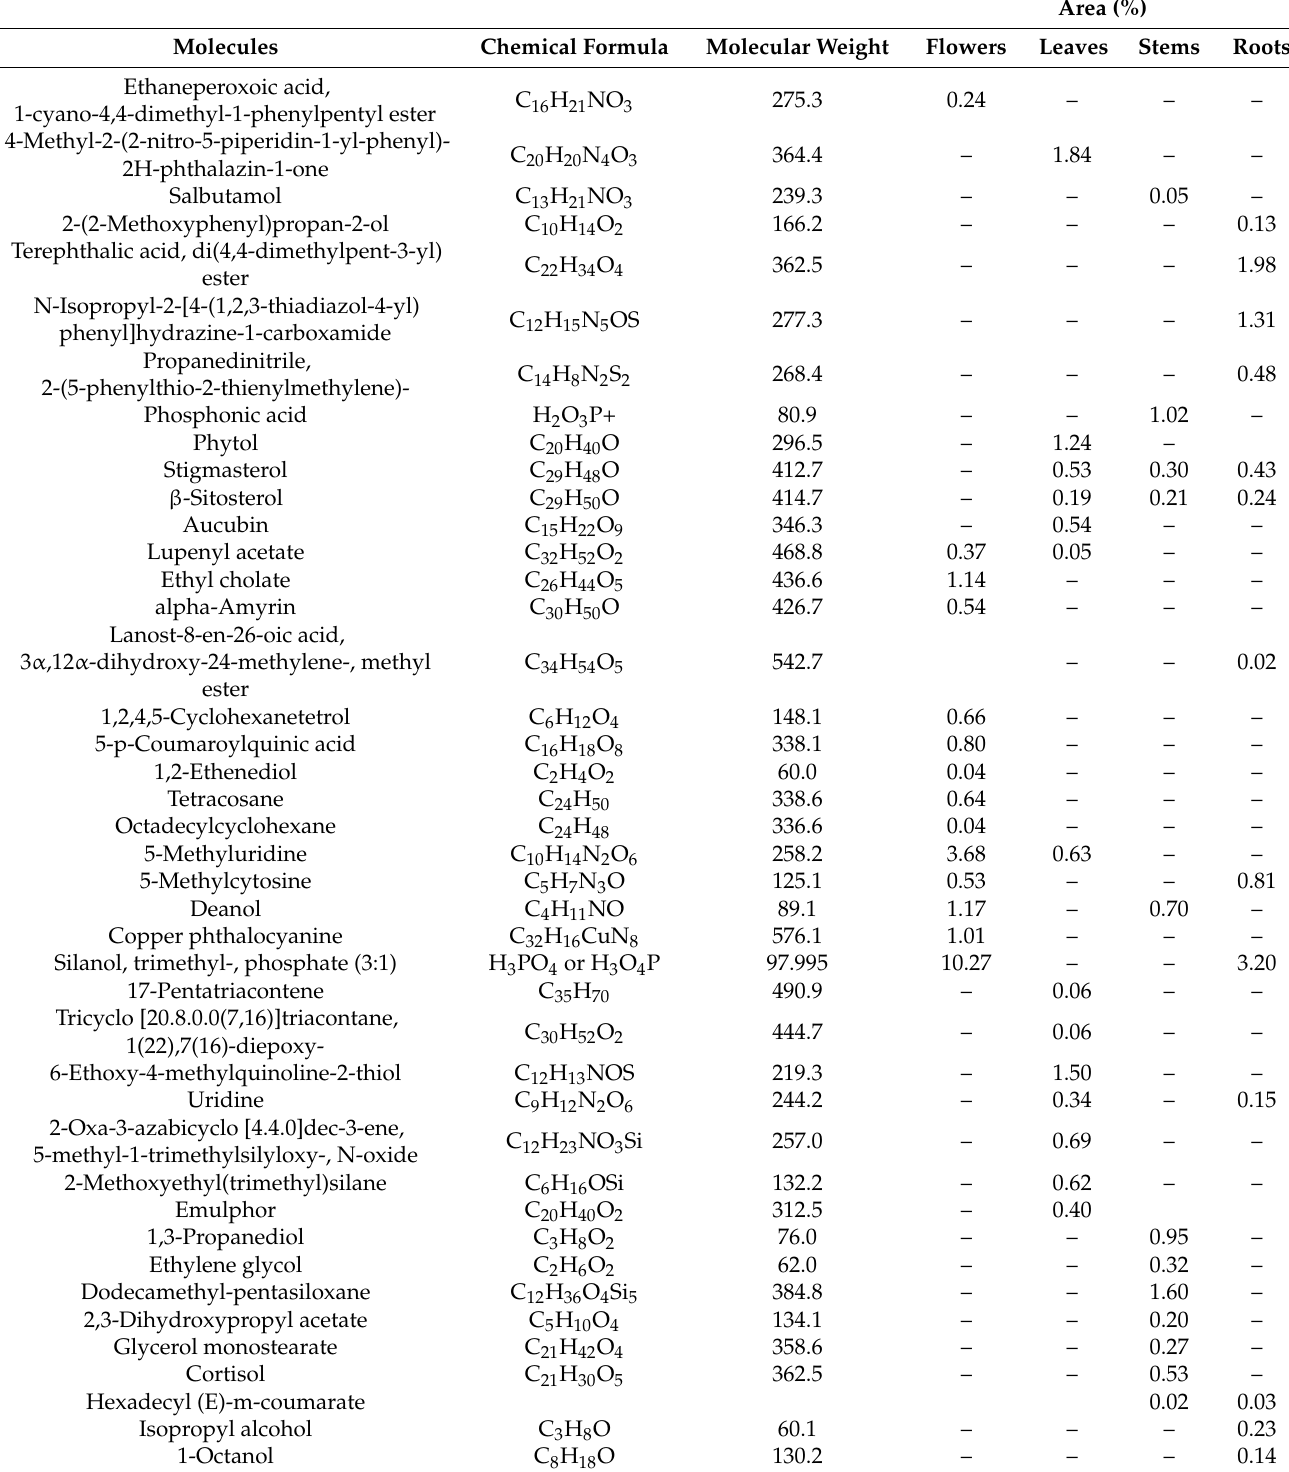
Table 9. Chemical composition of other molecules of derivatized methanolic extracts obtained by GC-MS.